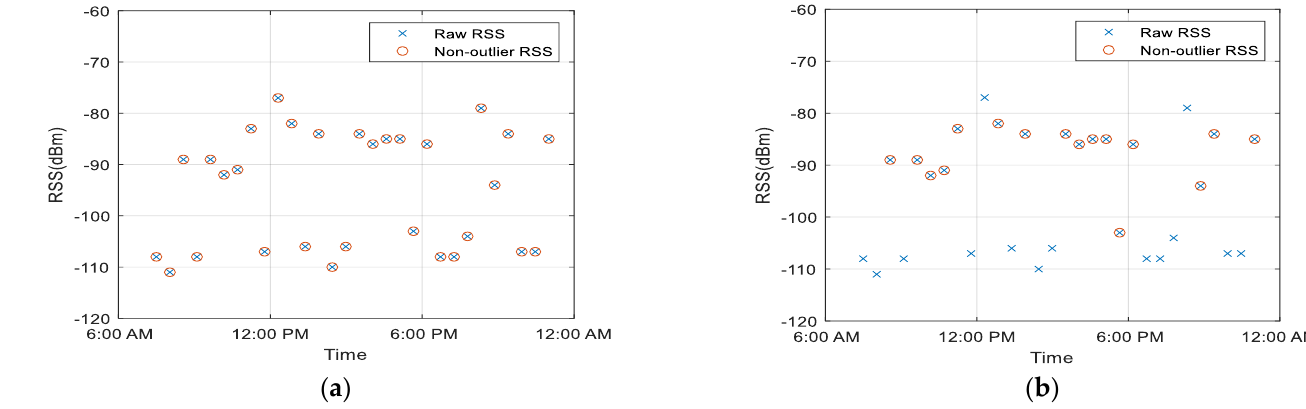
Figure 5. RSS outlier detection comparison for RSS Dataset 3. ( a ) 𝑆 𝑛 scale estimator, and ( b ) MAD scale estimator.